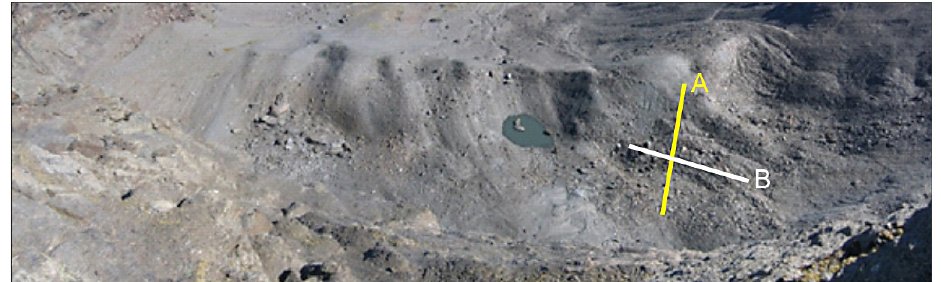
Figure 2. Distribution of the geophysical prospection transects conducted across the rock glacier in the eastern third of the Corral del Veleta.